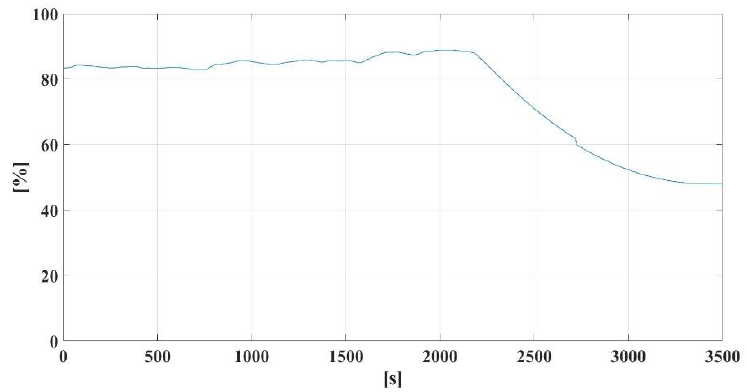
Figure 14. Field test result 2: output power of ESS.